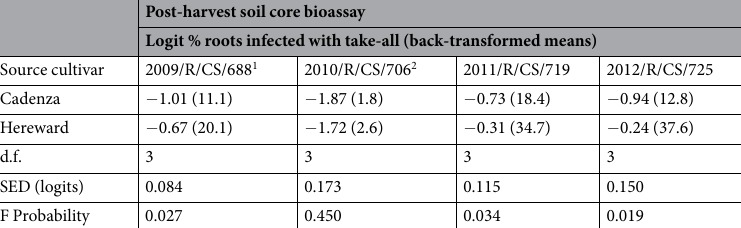
Table 1. Take-all infectivity of the soil after harvest of the source cultivars (Cadenza and Hereward) grown as a first wheat crop in the rotation. 1 Rothamsted field trial codes. 2 Dry weather from April-July 2010 restricted take- all